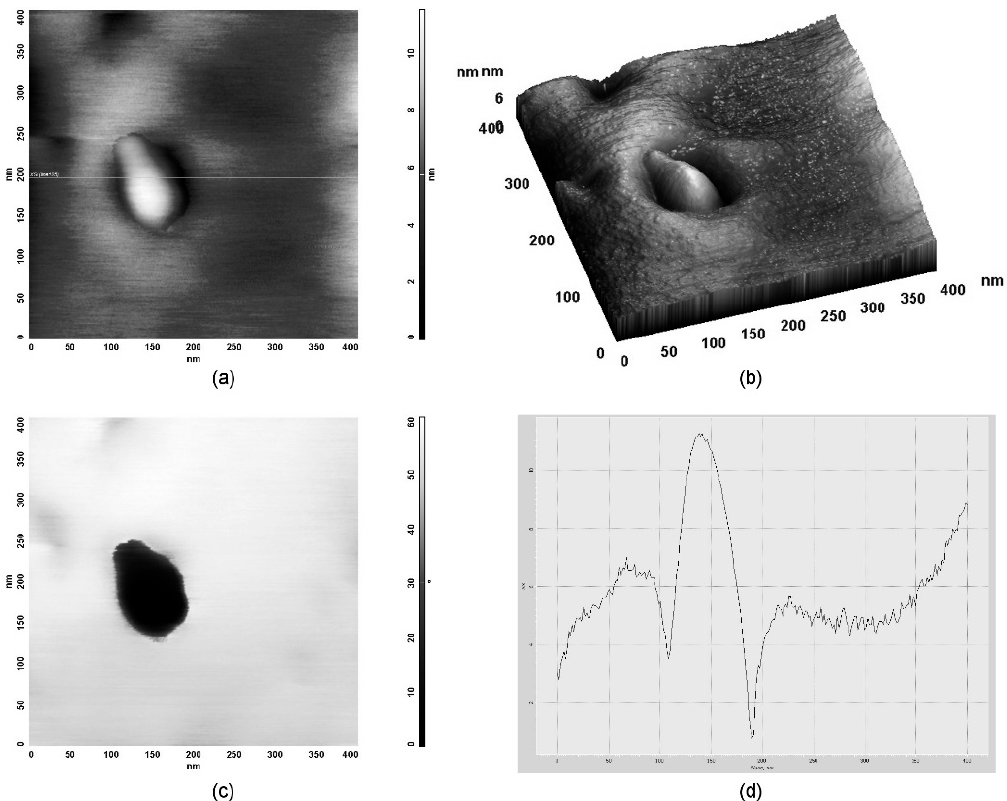
Figure 27. AFM-images of magnesium hydrosilicate NT on the surface of polymer matrix at 5 wt % of nano-filler content: topography ( a ); 3D image ( b ); phase contrast ( c ) and profile ( d ) [142].